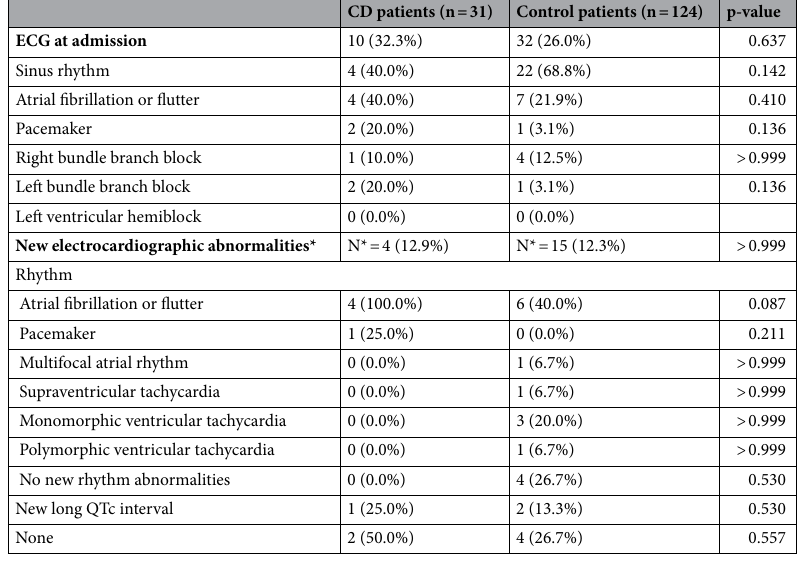
Table 3. Electrocardiographic characteristics of the study population at baseline and new abnormalities at follow-up. *New electrocardiographic abnormalities through in-hospital follow-up, and number of patients in